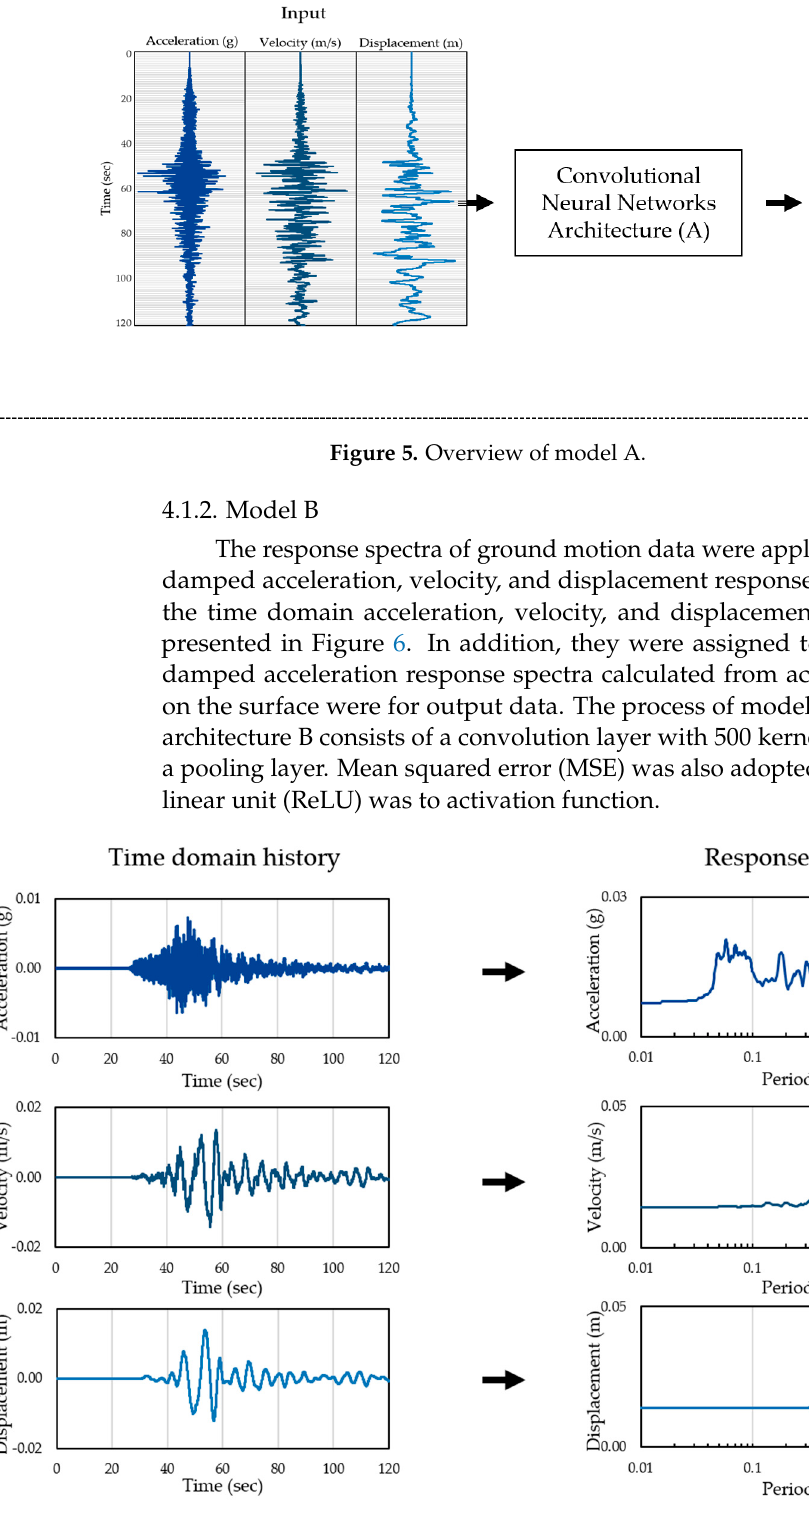
Figure 6. Input data preprocessing for model B.